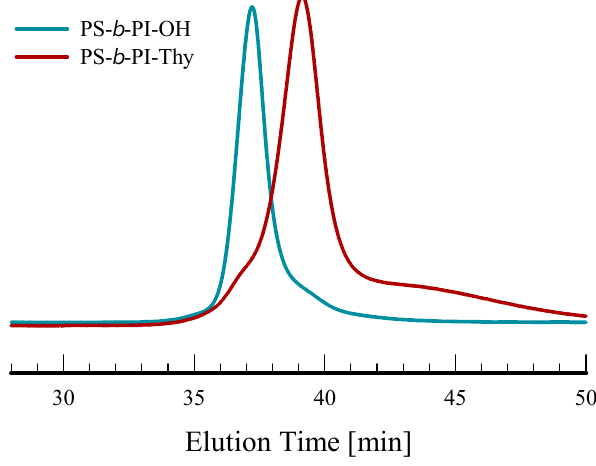
Figure 9. SEC traces of the samples PS ‐ b ‐ PI ‐ OH and PS ‐ b ‐ PI ‐ Thy.